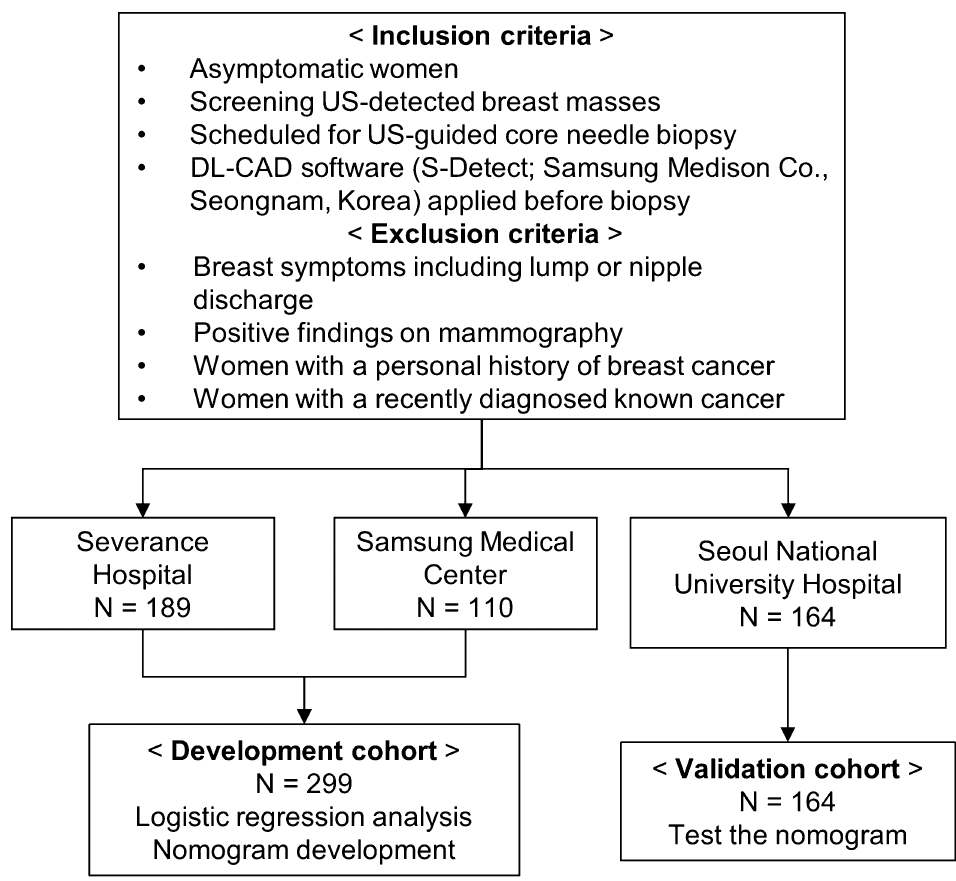
Figure 4. Flowchart of patient selection. DL-CAD = deep learning based computer-aided